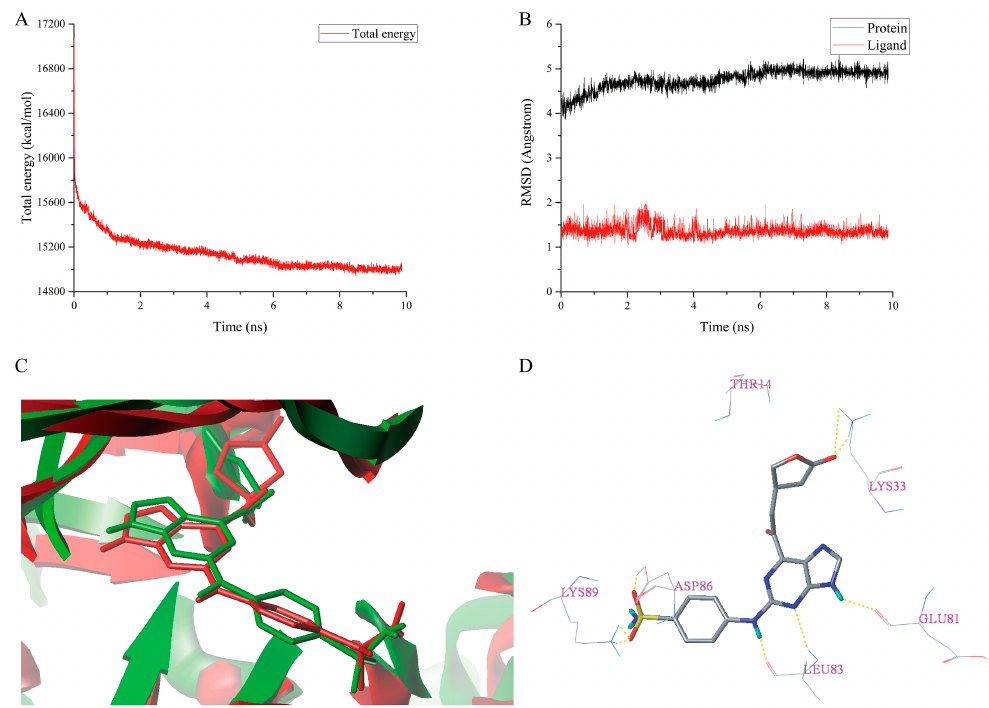
Figure 7. MD simulations result of the complex 1H1S-I13 . ( A ) The total energy plot. ( B ) The RMSDs plot. ( C ) The superimposition of the initial docked structure (red) of complex 1H1S-I13 and the average structure (green) of MD simulation of complex 1H1S-I13 . ( D ) The conformation of I13 after MD simulations. Hydrogen bonds were shown as yellow dashed lines and non-polar hydrogens were removed for clarity.